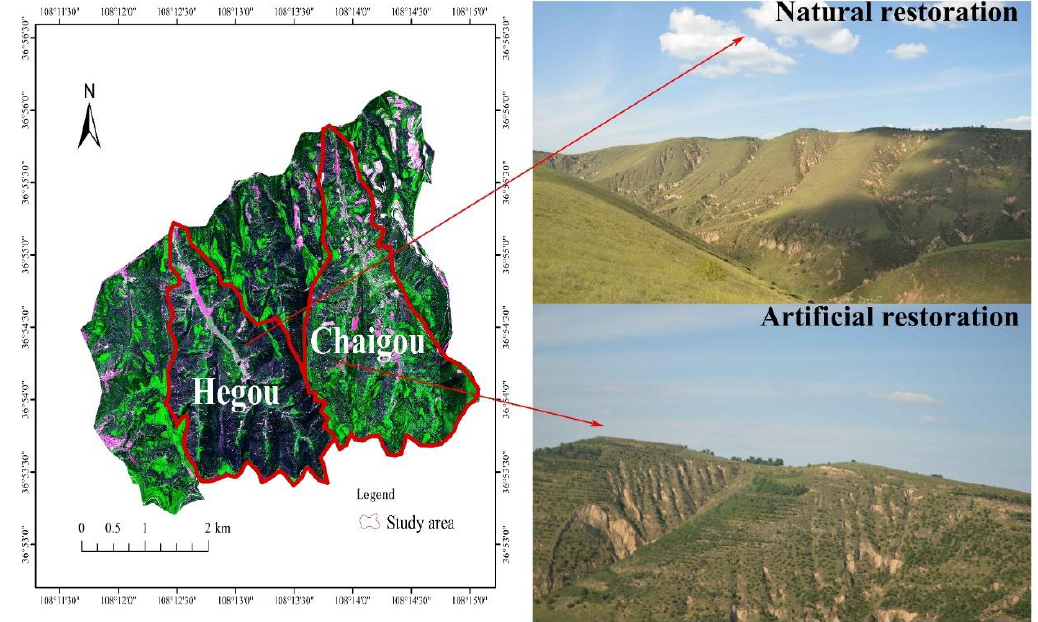
Figure 1. Sample location spot graph.